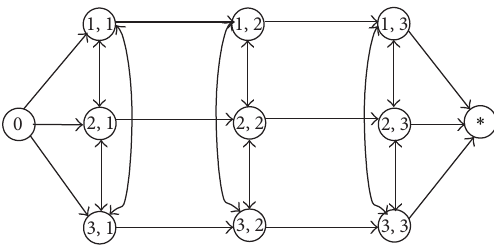
Figure 3: Disjunctive graph of a 3 × 3